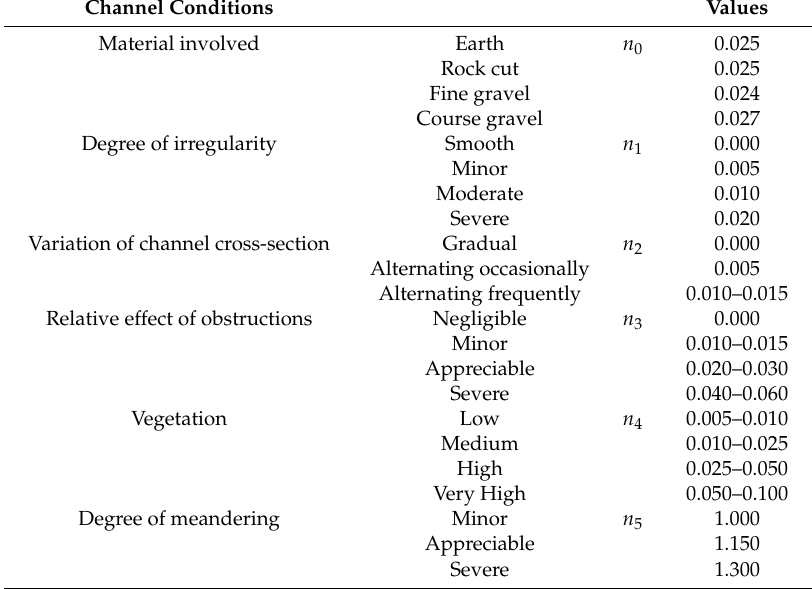
Table 2. Values for the computation of the roughness coefficient